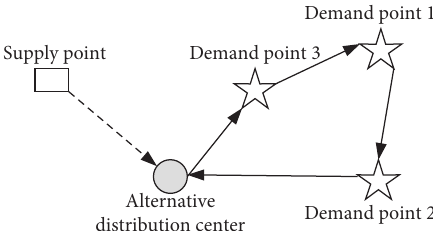
Figure 1: Schematic diagram of refrigerated vehicle distribution